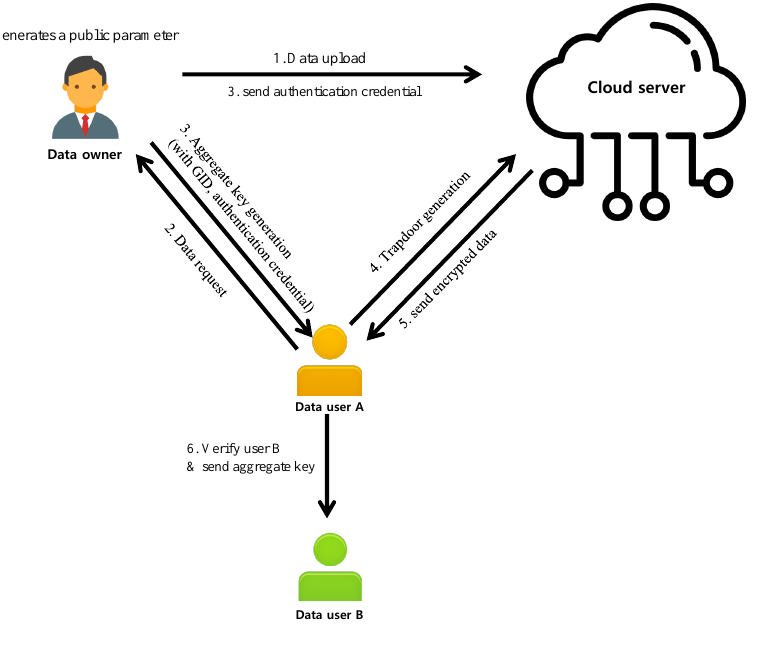
Figure 1. Proposed system